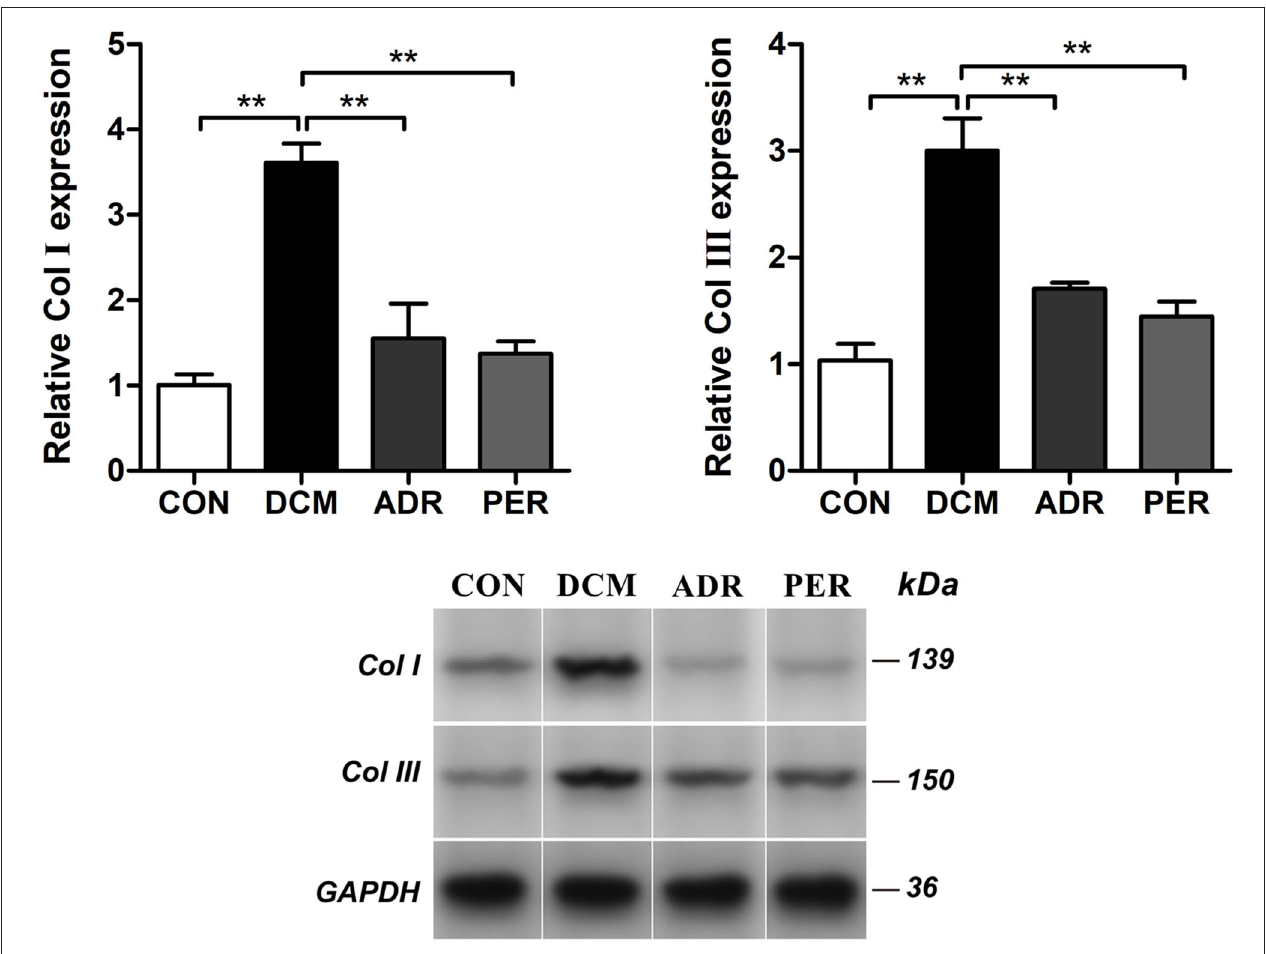
FIGURE 4 | Effects of ADR on relative expression of Col I and Col III in myocardial tissue in DCM rats. Compared to DCM group, the relative expression of Col I and Col III proteins decreased in ADR and PER group. CON, control; DCM, diabetic cardiomyopathy; ADR, adropin; PER, perindopril; Col, collagen. Values are expressed as mean ± standard deviation. * P < 0.05, ** P <